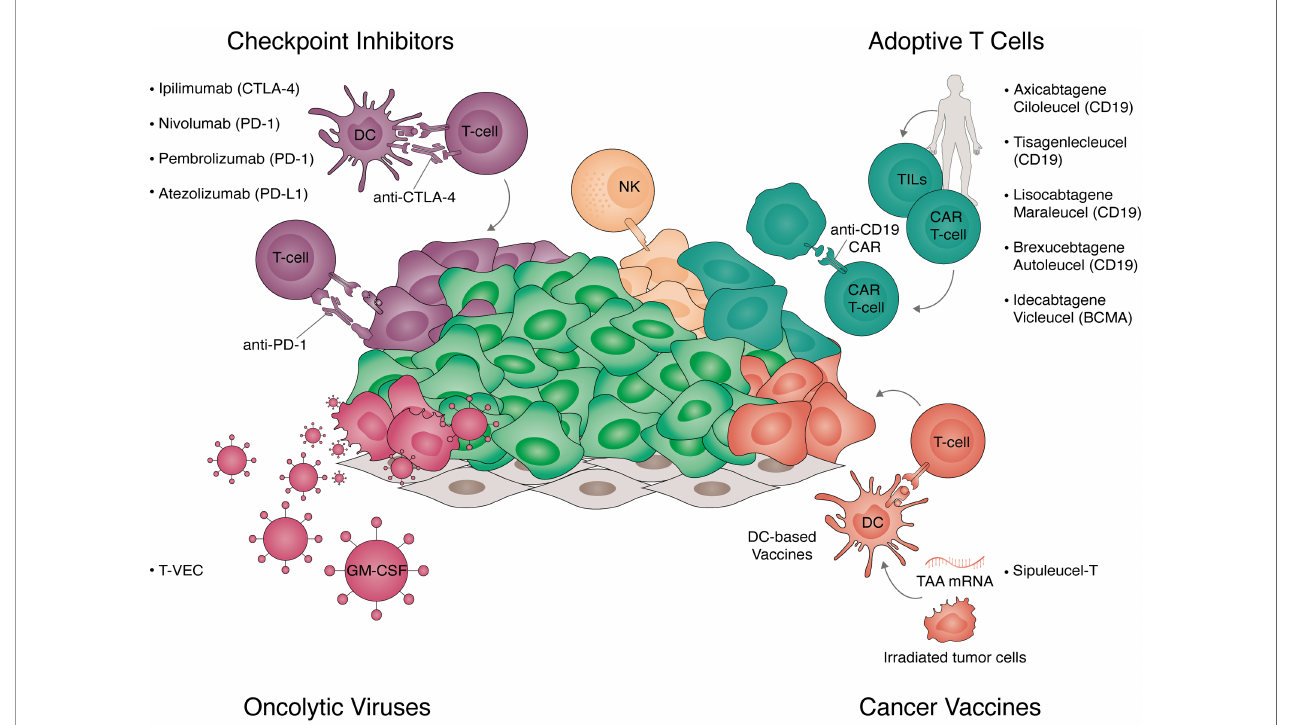
FIGURE 1 | Strategies for cancer immunotherapy. Overview of the strategies for immunotherapy translated to clinical practice. Approved strategies include immune checkpoint inhibitors, adoptive T-cell therapy, cancer vaccines, and oncolytic viruses. Checkpoint inhibitors (top left panel) are antibodies targeting key negative regulators of T-cell activation. These include receptors expressed in T-cells targeted with anti-cytotoxic T-lymphocyte associated protein 4 (CTLA-4) (ipilimumab), anti- programmed cell death protein 1 (PD-1) (nivolumab, pembrolizumab) and receptors expressed in tumor cells targeted with anti-programmed death-ligand 1 (PD-L1) (atezolizumab). Adoptive T-cell transfer (top right panel) are autologous cellular therapies currently targeting hematological tumors. Approved Chimeric Antigen Receptor (CAR) T-cells target CD19 (axicabtagene ciloleucel, tisagenlecleucel, brexucabtagene autoleucel, and lisocabtagene maraleucel) or B-cell maturation antigen (BCMA) (idecabtagene vicleucel). Additionally, tumor in fi ltrated lymphocytes (TILs) expanded ex vivo and natural killer (NK) cells are currently in clinical trials. Cancer vaccines (bottom right panel) exploit the antigen presentation capacity of dendritic cells (DC) to trigger polyclonal T-cell responses to tumor-associated antigens (TAA). These include irradiated tumor cells expressing granulocyte-macrophage colony-stimulating factor (GM-CSF, GVAX), DCs loaded with tumor antigens (sipuleucel-T), or the delivery of mRNA in vivo encoding multiple TAAs. Oncolytic viruses (bottom left panel) target cancer cells own vulnerability to viral infections while inducing immunogenic cell death. Talimogene laherparepvec (T-VEC) is an approved intra-tumoral therapy consisting of a type-1 herpes virus expressing